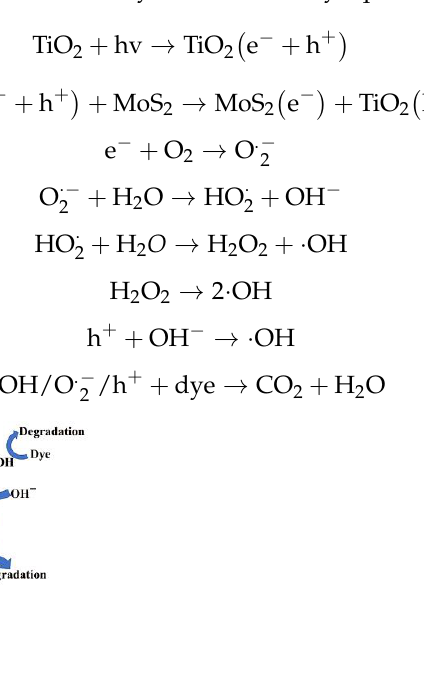
Figure 10. Assumed mechanism of the photodegradation of dyes with PI/TiO 2 @MoS 2 heterostruc- tures.